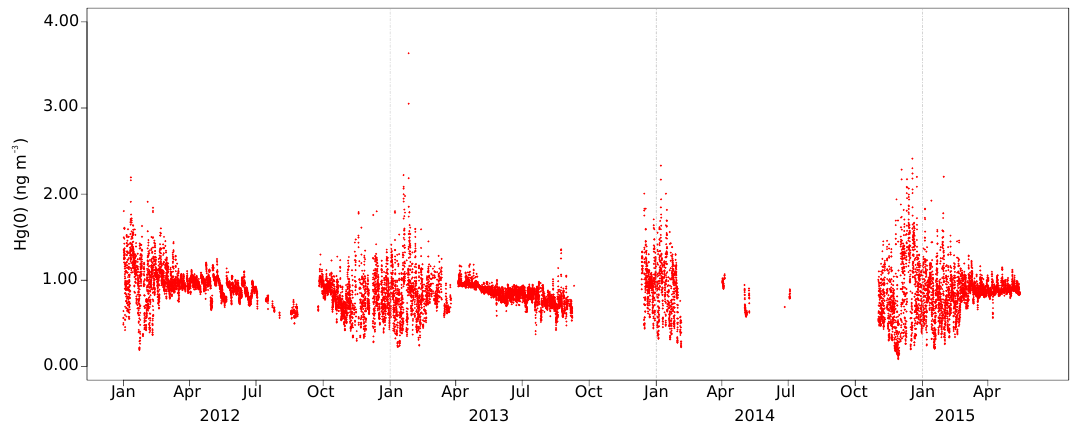
Figure 2. Hourly averaged Hg(0) concentrations (ngm − 3 ) measured at DDU from January 2012 to May 2015. Missing data are due to instrument failure or QA/QC invalidation. Hg(0) concentrations were highly variable during the sunlit period as compared to wintertime (May–August) suggesting a photochemically induced reactivity at this period of the